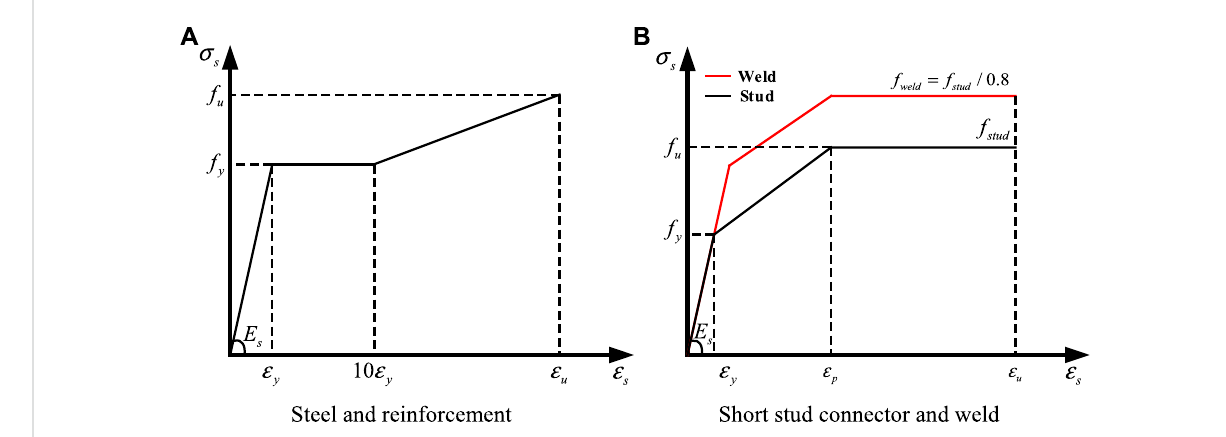
FIGURE 13 Stress-strain relationship of steel, short stud connector and weld.